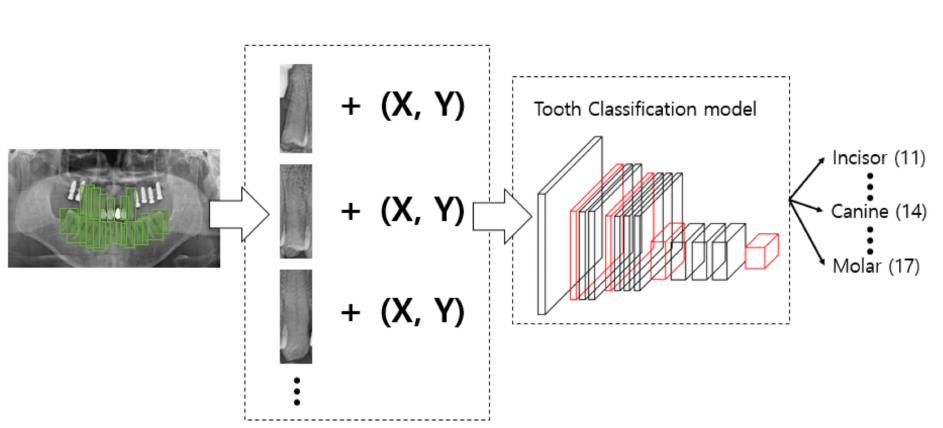
Figure 7. Algorithm model for dental object detection.